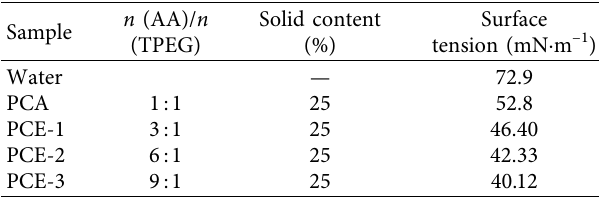
Table 2: Surface tension of PCE-1, PCE-2, and PCE-3.